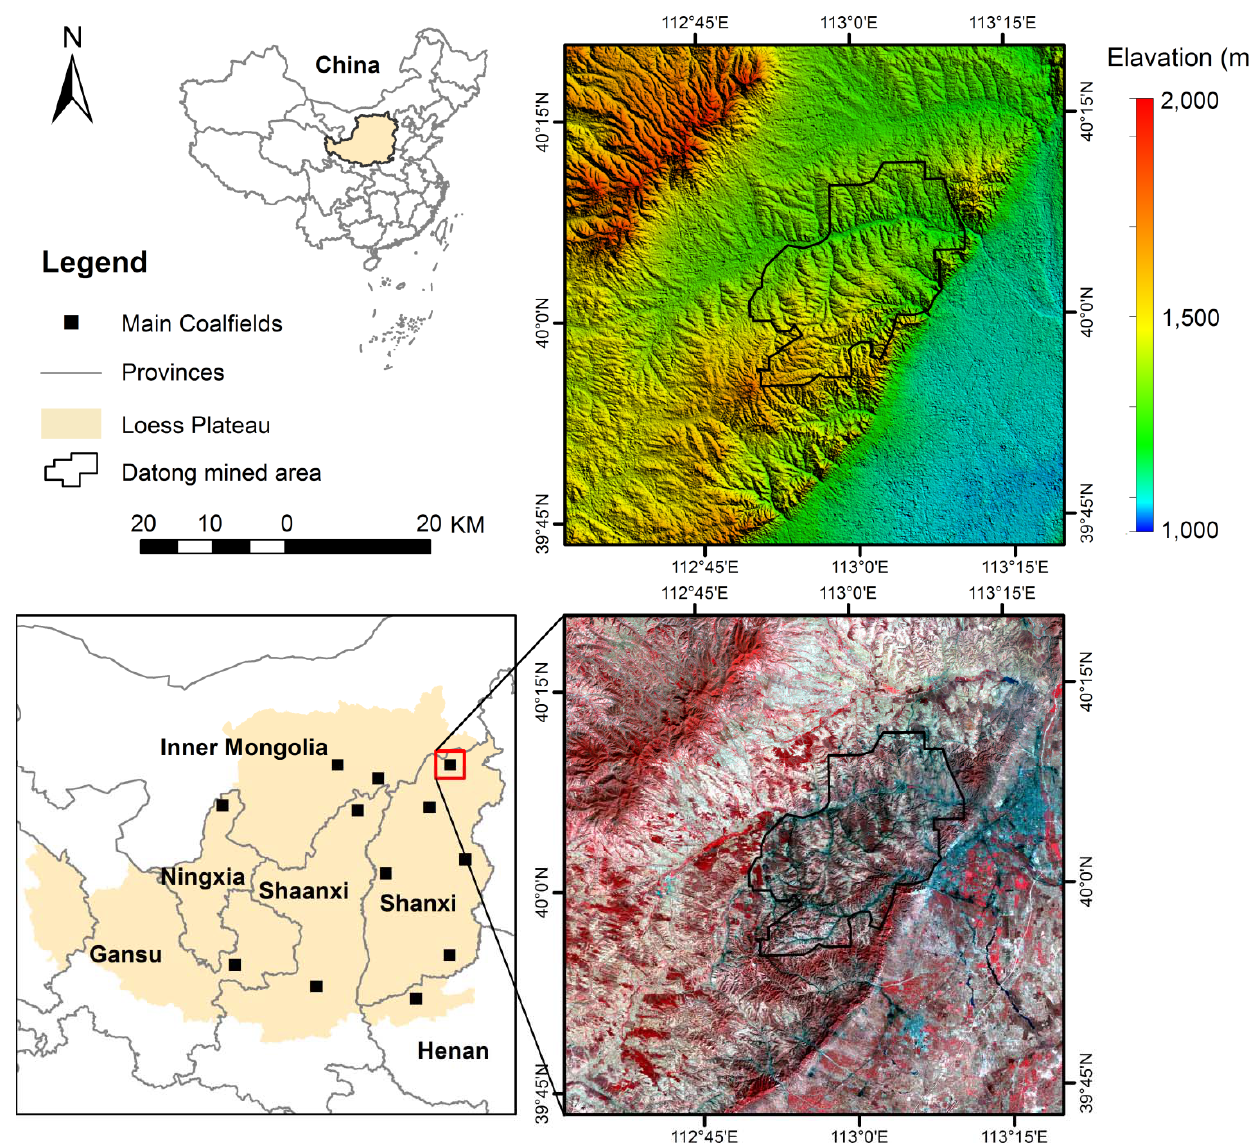
Figure 1. Location of the study area. The boundary of the Loess Plateau was provided by the National Development and Reform Commission. The lower right figure shows the Landsat image using an RGB (red-green-blue) composite of near infrared (NIR), red and green. The upper right figure shows the digital elevation model (DEM) obtained from the International Scientific Data Service Platform